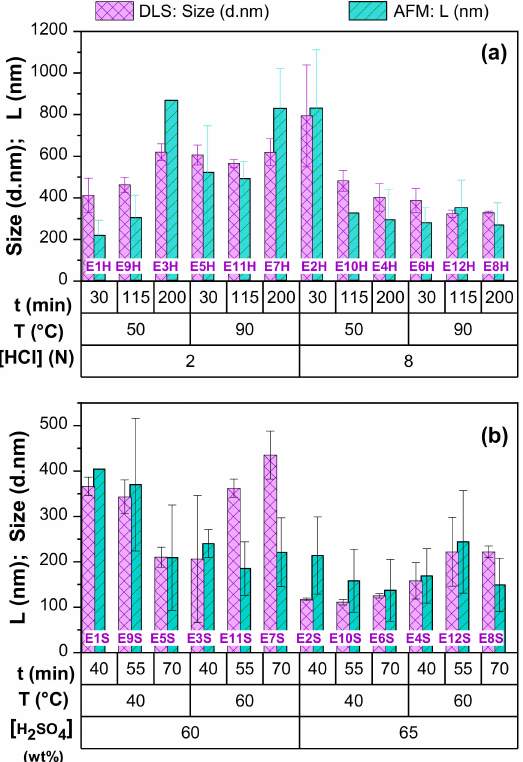
Figure 9. CNC length comparison measured using AFM and DLS for both acid hydrolysis: ( a ) CNC-H ( b )